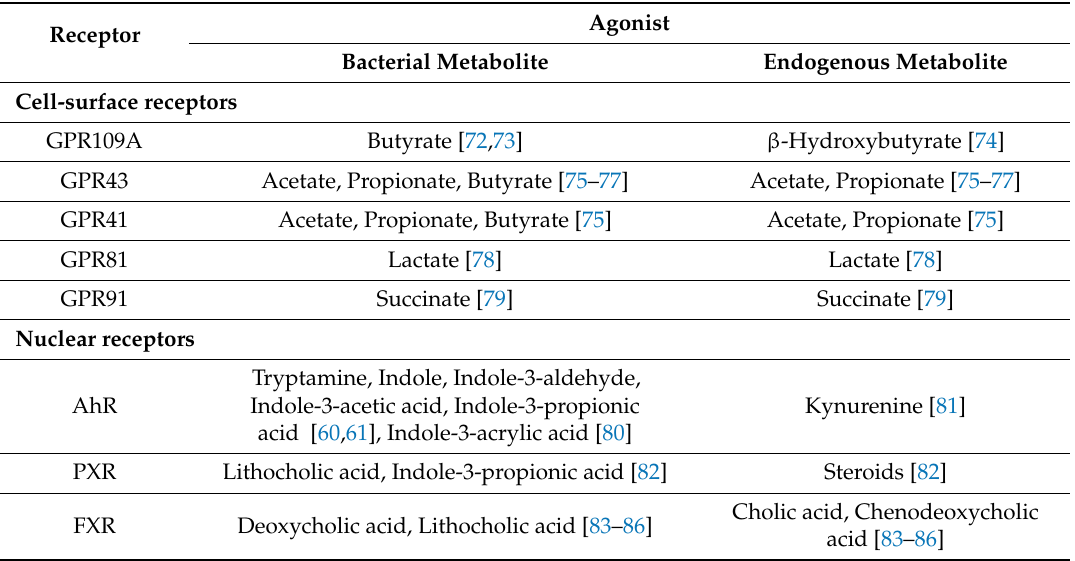
Table 1. Receptors involved in host-bacteria communication in the